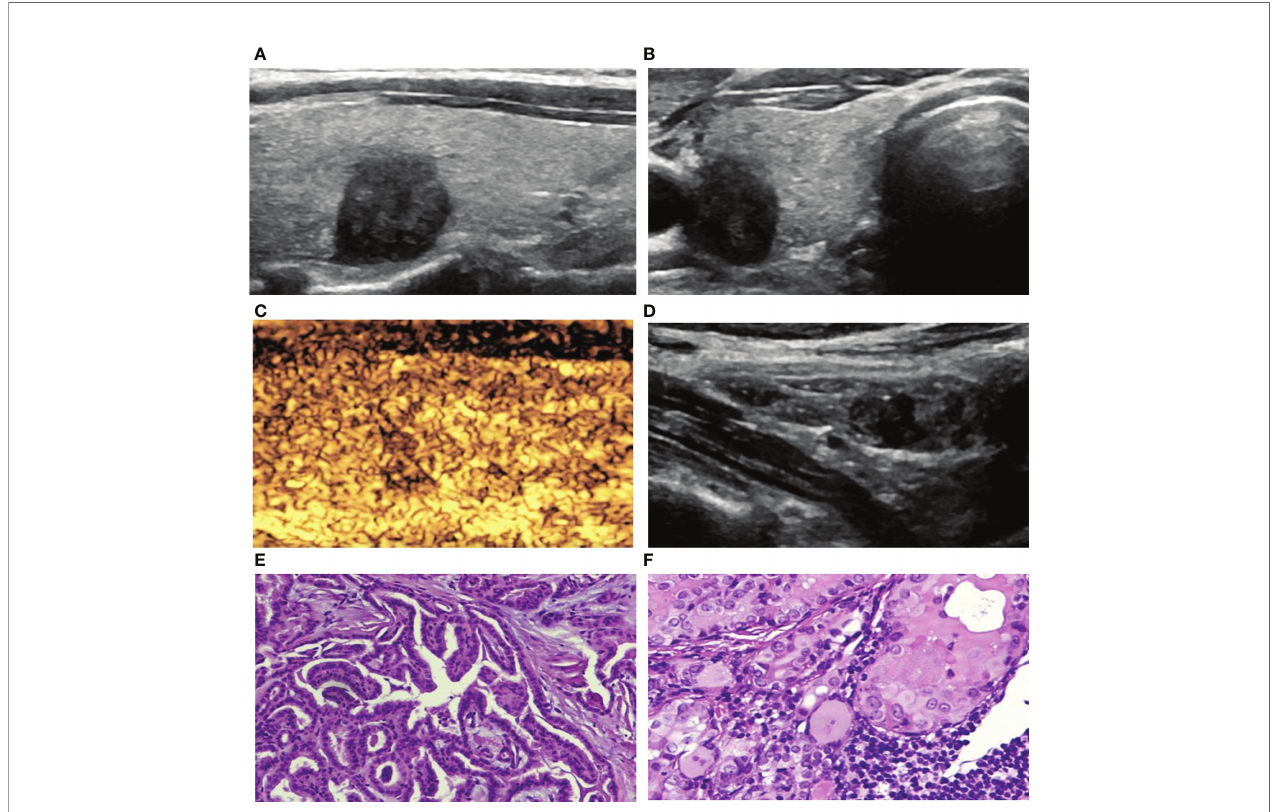
FIGURE 4 | A 42-year-old woman with PTC. (A) Preoperative ultrasound images showing that the size of the tumor was approximately 1.00*0.77*1.03 cm in the right lobe with hypoechogenicity, an irregular margin, a poorly de fi ned boundary and a taller-than-wide shape. (B) Transverse sonogram showing that the contact range with the capsule was approximately 25%-50%. (C) CEUS showing heterogeneous hypoenhancement in the nodule. (D) Metastatic lymph node showing that the normal structure disappeared, and microcalci fi cation was detected inside. (E) Surgical specimen con fi rming PTC (HE, original magni fi cation, ×100). (F) Surgical specimen con fi rming cervical lymph node metastasis from PTC (HE, original magni fi cation, ×100).